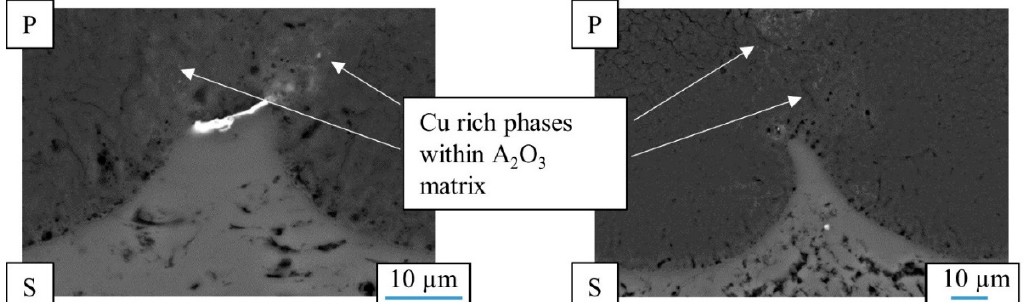
Figure 4. Cross section of the oxide/substrate interface of a PEO coating produced on thermally sprayed aluminum comprised of copper particles (P – PEO layer, S – Substrate). The brighter regions reflect a higher atomic number of the displayed material (SEM in BSE-mode – element contrast).